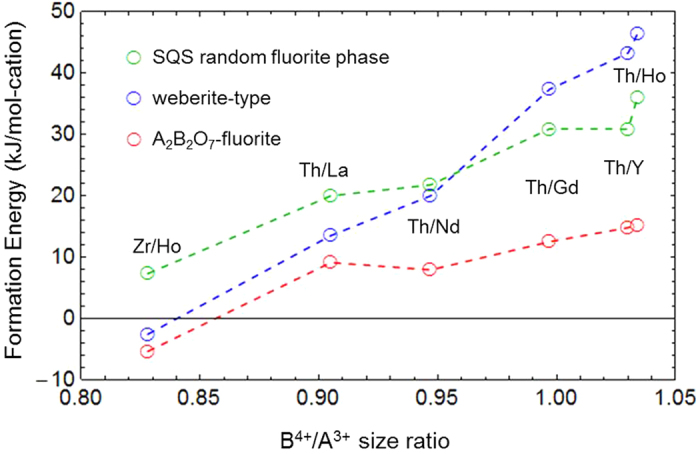
Formation energy vs. cation size ratio.Formation energies (kJ/mol-cation) of lowest-energy A2B2O7-fluorite, lowest-energy weberite-type, and SQS random phase configurations (88 atom) as a function of B4+/A3+ size ratio are plotted for Ho2Zr2O7 and RE2Th2O7 systems.